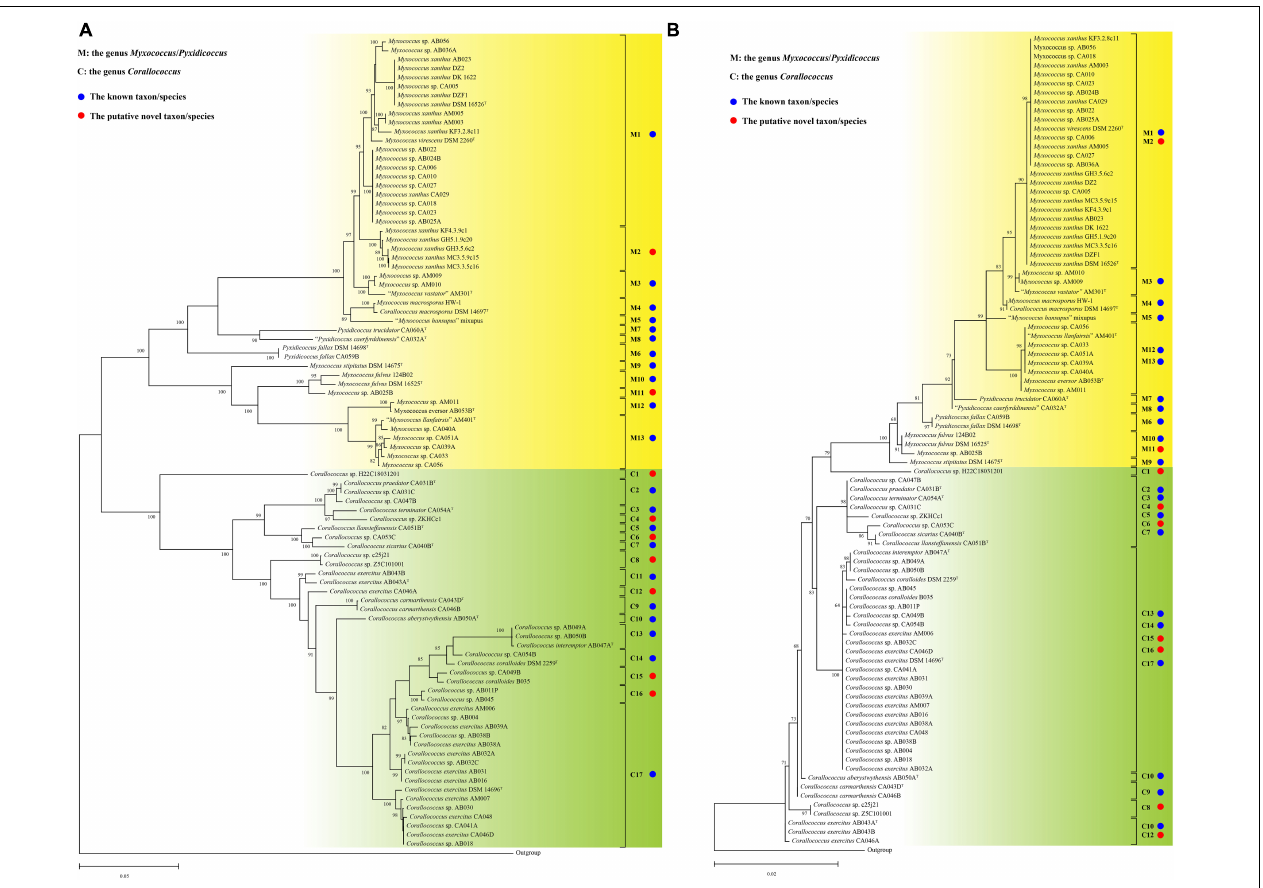
FIGURE 2 | The ML phylogenetic trees based on complete gyrB (A) and 16S rRNA gene (B) sequences. The ML trees of the gyrB and 16S rRNA gene were reconstructed using the IQ-TREE with the TIM + F + I + G4 and TIM2 + F + R2 models, respectively. The species names are effectively but not yet validly published and thus are in quotation marks. Strain Aggregicoccus sp. 17bor-14 was used as an outgroup. Bootstrap values great than 80% in gyrB -based tree and 50% in 16S rRNA-based tree were shown at branch points. Bar: 0.05/0.02 represents the number of substitutions per